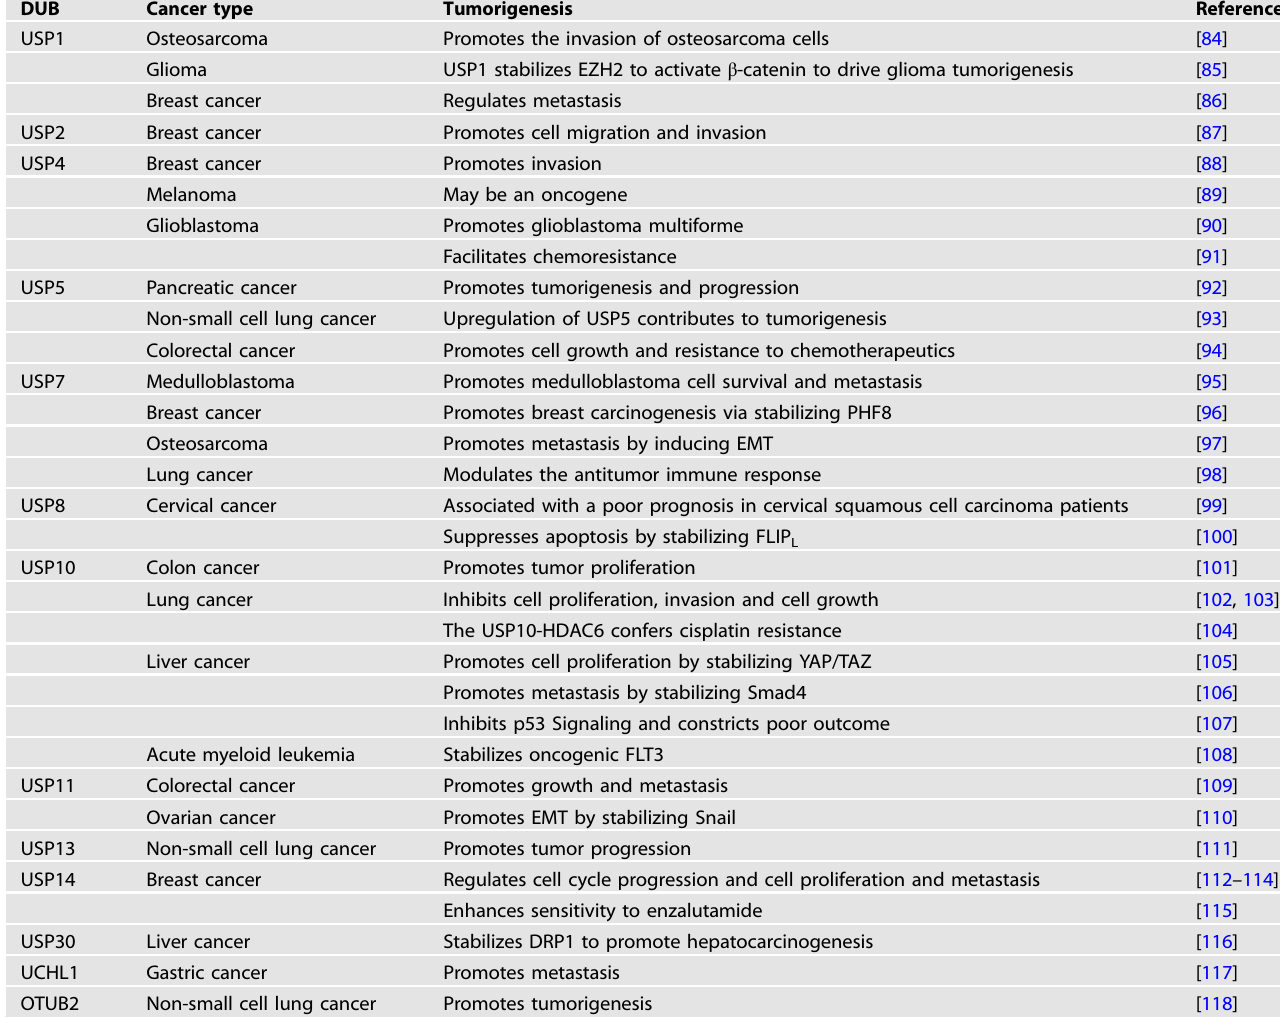
Table 1. Other DUBs and